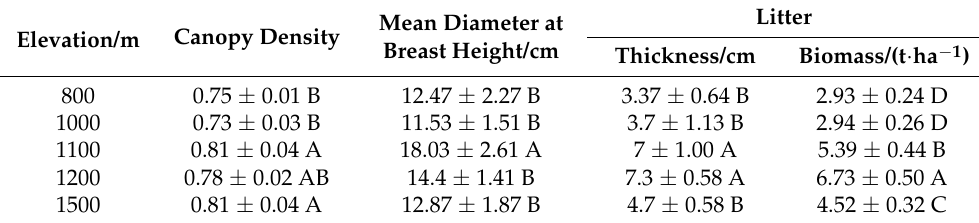
Table 1. Summary of site characteristics along the elevation gradients. Elevation/m Canopy Density